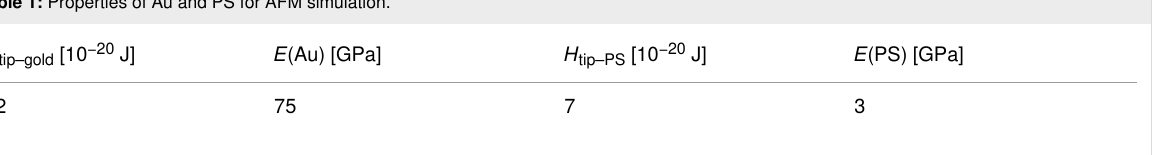
Table 1: Properties of Au and PS for AFM simulation.